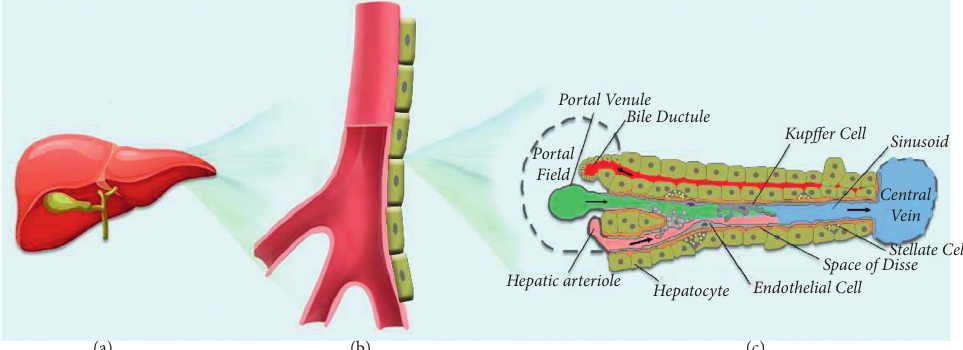
Figure 2: Liver anatomy. (a) Entire organ, (b) blood supply, and (c) schematic of cells, ducts, and blood vessels based on the research article